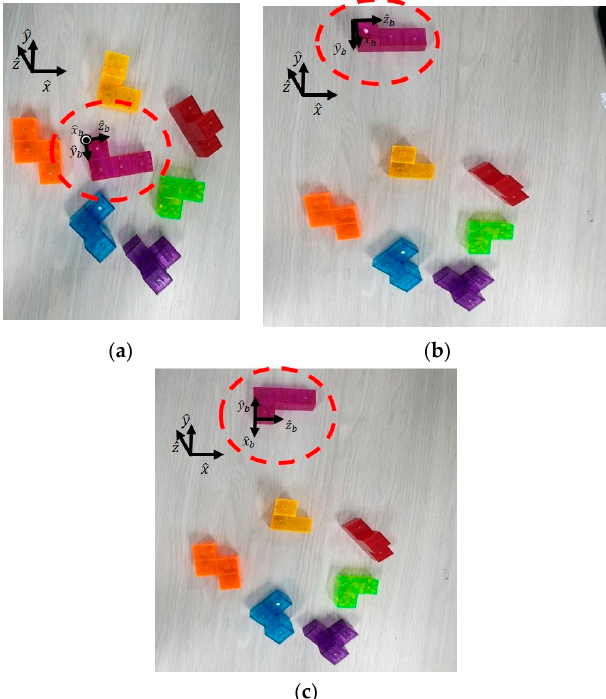
Figure 4. Part manipulation for L-shaped part (encircled in ( a – c )) using orientation graph search. ( a ) Initial poses of the parts. ( b ) Intermediate pose of L-Shaped part after picking from its initial pose. ( c ) Final pose of L-shaped part. In the initial pose of the part, it can only be picked with the vertical approach direction of hand due to other parts in the neighborhood. In first manipulation, part is moved from orientation +𝑥0 (in (a)) to −𝑦0 (in ( b )). In second manipulation, part is moved from −𝑦0 (in ( b )) to −𝑥0 (in ( c )).